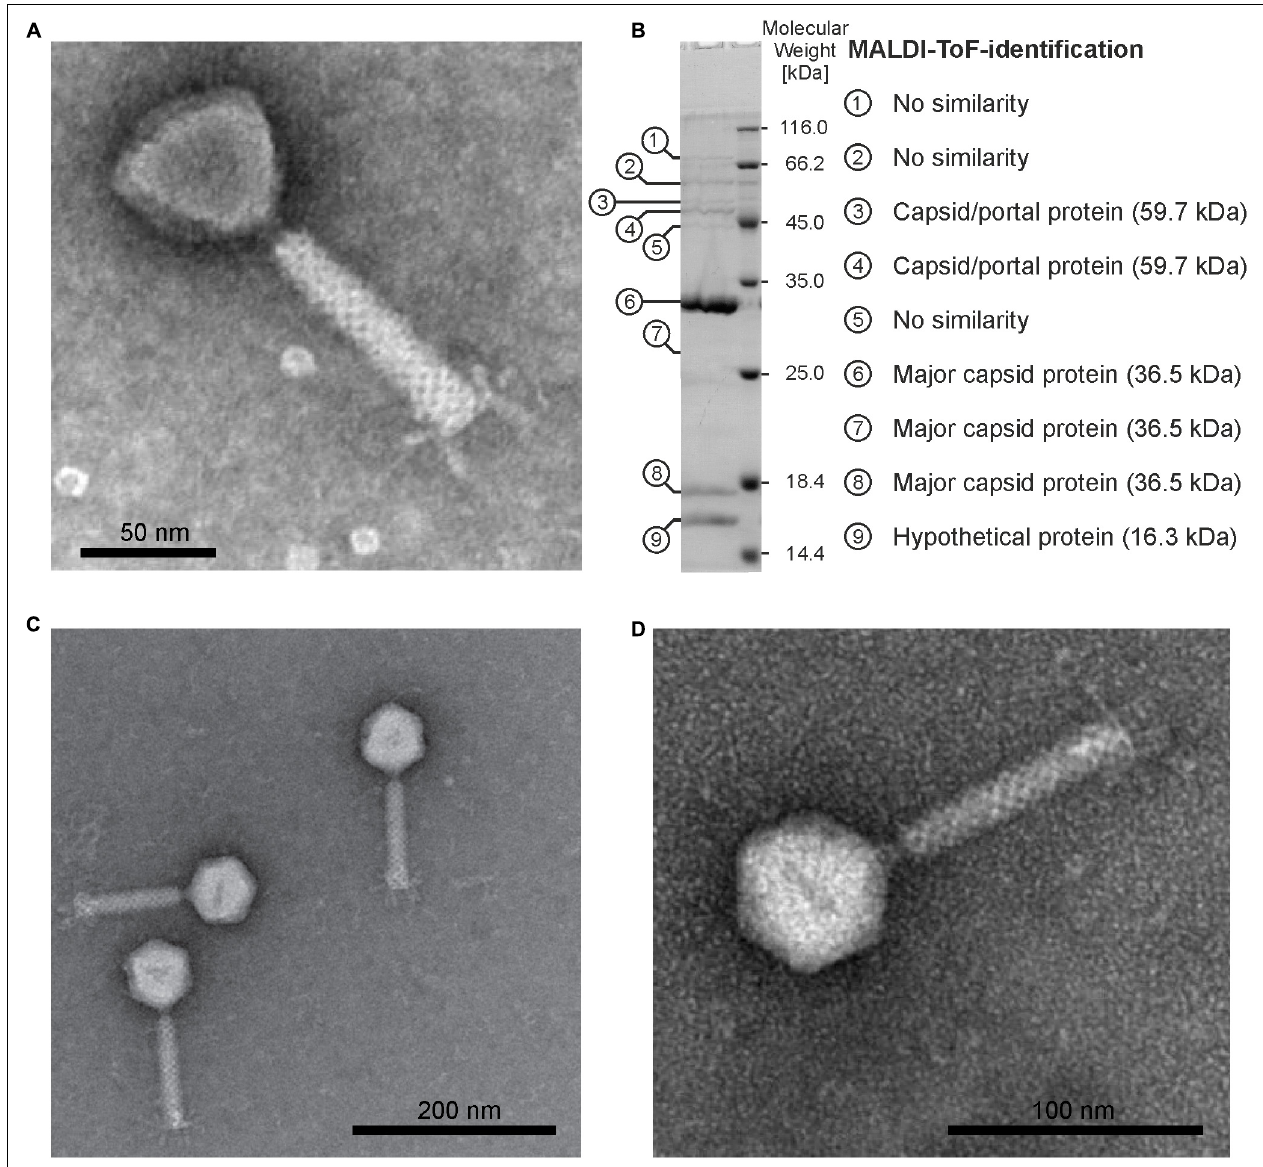
FIGURE 1 | Morphology of (cid:56) E058 and (cid:56) E067 and structural proteins of (cid:56) E067. (A) Electron micrograph of (cid:56) E067 (virion dimensions based on eight measured particles: head 55.4 ± 1.4 nm × 48.7 ± 0.8 nm, tail 102.0 ± 3.1 nm × 17.2 ± 0.4 nm). (B) SDS-PAGE and MALDI-ToF analysis of (cid:56) E067 structural proteins. (C) and (D) Electron micrographs of (cid:56) E058 (virion dimensions based on ten measured particles: head 61.1 ± 2.3 nm, tail 112.5 ± 7.4 nm × 19.8 ± 0.6 nm).